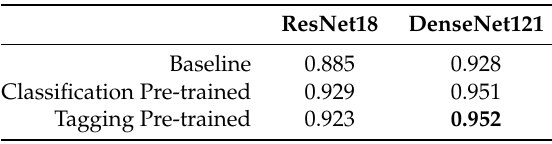
Table 3. Similarity matching performance (mAP).